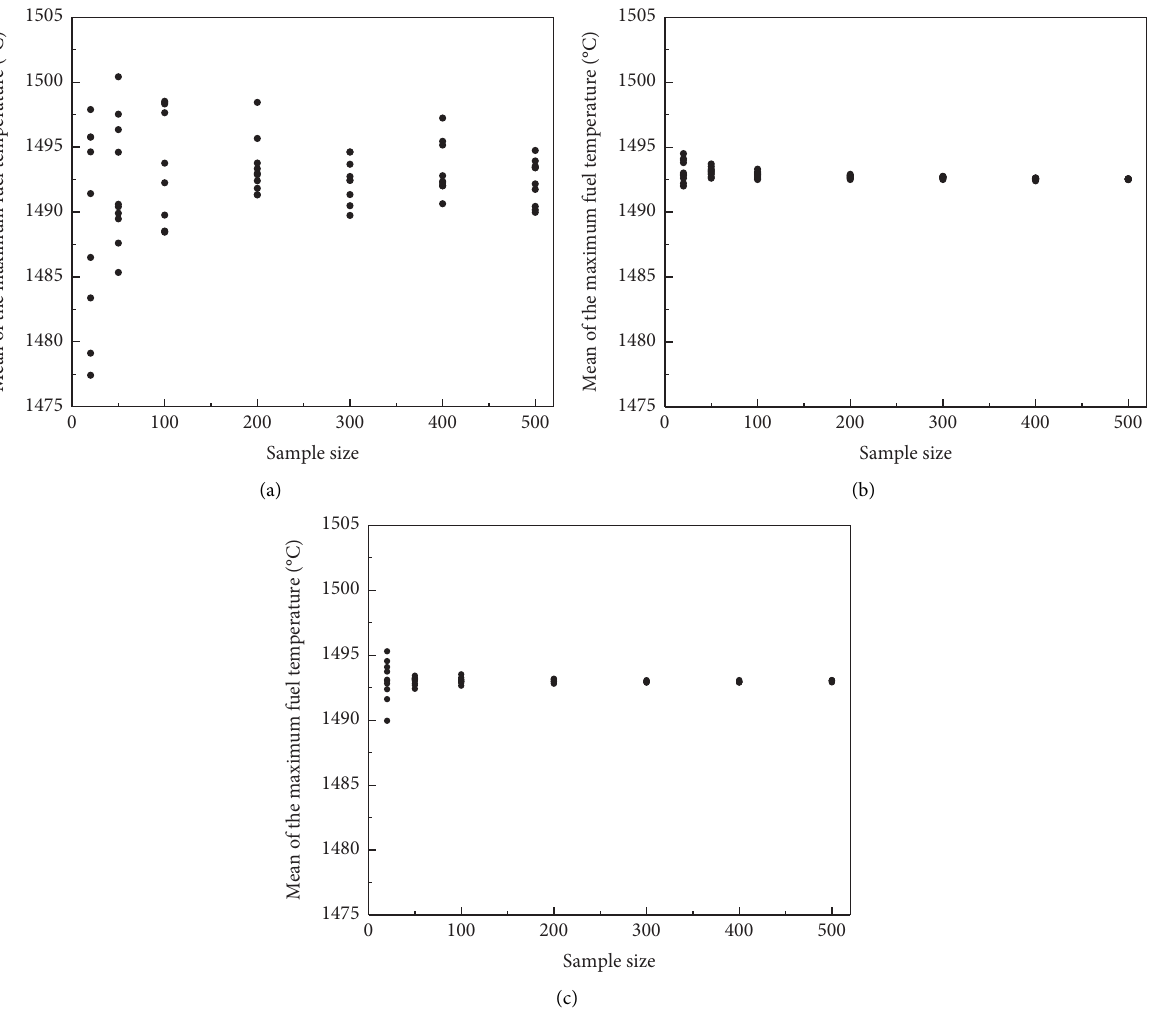
Figure 15: The 10 sets of the mean of the maximum fuel temperature due to the random samples generated by (a) SRS, (b) LHS, and (c)